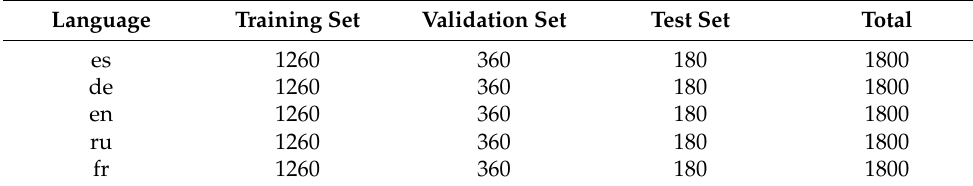
Table 1. Common Voice data set